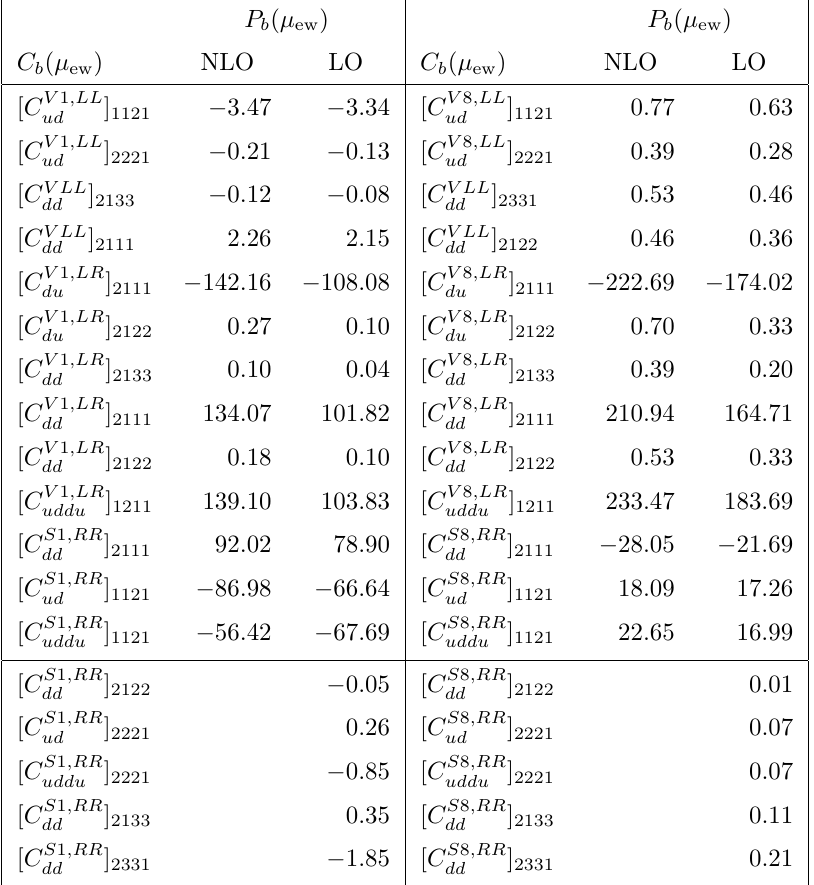
= 160 GeV. The upper part is due to operators ew at LO in 8 g